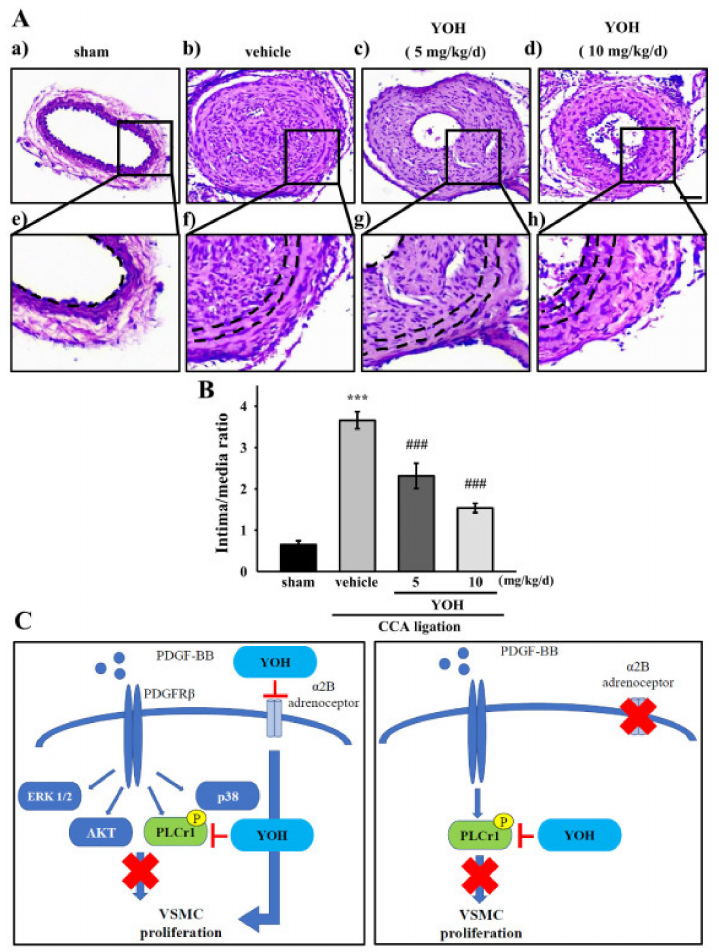
Figure 6. Effect of YOH on neointimal formation induced in mouse model of CCA ligation. ( A ) C57BL/6 mice were treated with vehicle or YOH (5 or 10 mg/kg) for 21 days after CCA ligation. The carotid arteries were harvested after 21 days. All CCA cross sections were stained with H&E; the representative patterns were obtained from five independent experiments. Arrowheads indicate elastic lamina, and the black bar indicates 100 mm. ( a ) sham, ( b ) vehicle, ( c ) YOH (5mg/kg/d), ( d ) YOH 10 mg/kg/d; ( e – h ) magnified parts of ( a – d ); ( B ) Quantifications of mean intimal thickness and intimal–medial layer ratio. Data are presented as the mean ± S.E.M. ( n = 5 for each experimental group). *** p < 0.001 compared with the sham group; ### p < 0.001 compared with the injured group. ( C ) Schematic of the inhibitory mechanism of YOH in wild-type cells and VSMCs with α 2B-adrenergic receptor knockdown. YOH inhibited PDGF-BB-induced proliferation by suppressing PLC γ 1 phosphorylation but not ERK1/2, AKT, or p38. Similarly, YOH treatment still inhibited